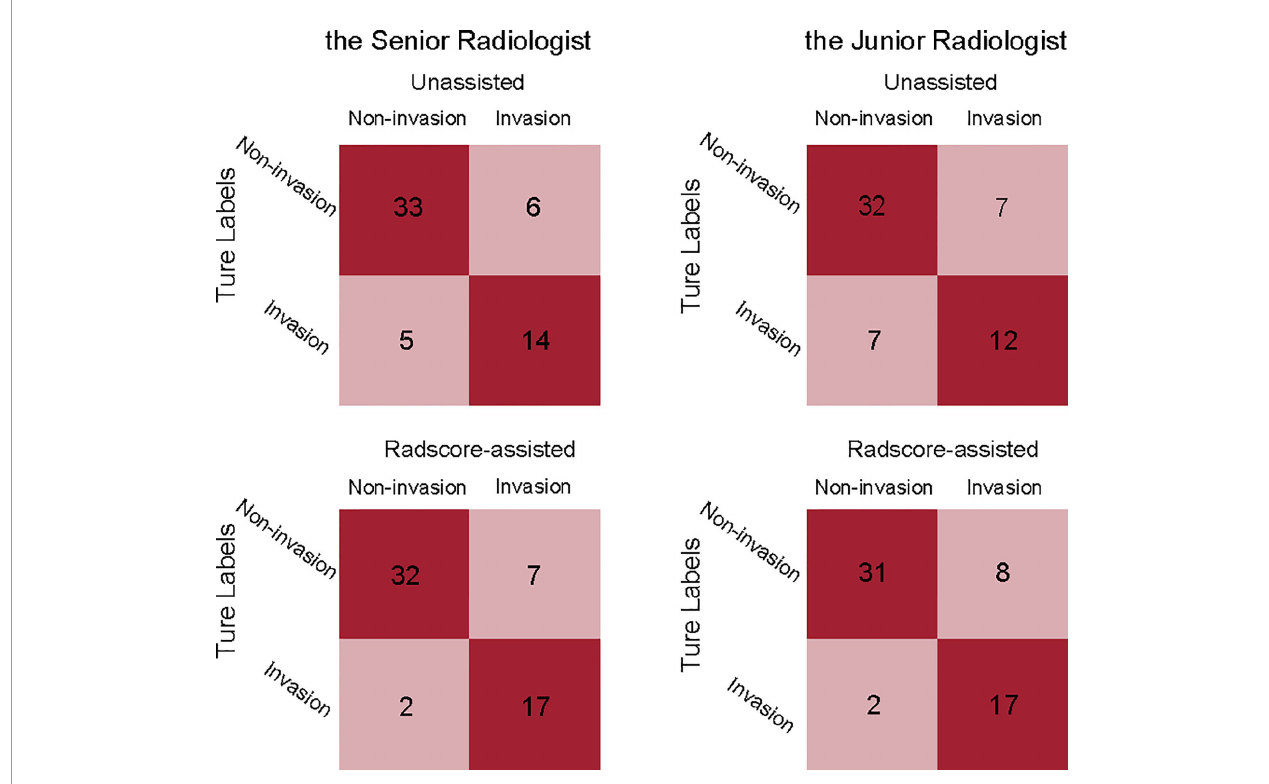
FIGURE 4 | Confusion matrices comparing the true labels and the diagnostic labels. Each plot illustrates performance on the validation cohort. left, the senior radiologist ’ s unassisted evaluation and Radscore-assisted evaluation; right, the junior radiologist ’ unassisted evaluation and Radscore-assisted evaluation. Radscore, radiomics score.